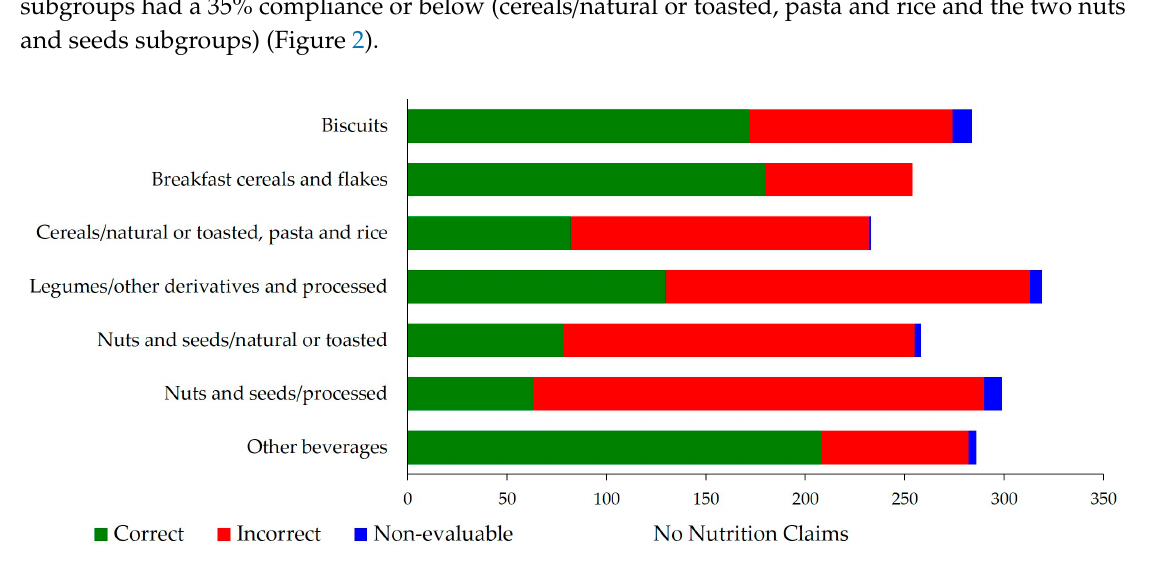
Figure 2. NCs compliance in main food subgroups (>200 NCs).